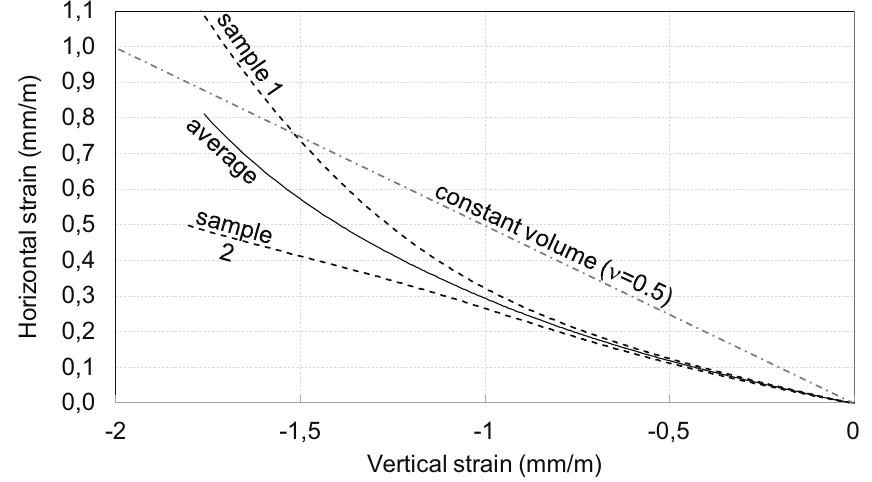
observed with increases in the stress/strength ratio and with in- creases in the l/h ratio. Figure 12 presents the horizontal and vertical strains for the l/h ratio of 0.5 for both samples and the mean value of the results. The dashed line represents the constant volume limit, which is de- termined when the ratio between vertical and horizontal strains is constant and equal to 0.5. The samples behave almost the same up to a vertical strain of 0.7 mm/m, the limit of linear behaviour as showed in Figure 10, after which the behaviour is distinct probably due to crack initiation and propagation inside the samples. Figure 13 presents the horizontal and vertical strain measure - ments for samples with l/h ratio of 1.0. Unlike the behaviour of the samples with l/h ratio of 0.5, the behaviour of the samples with